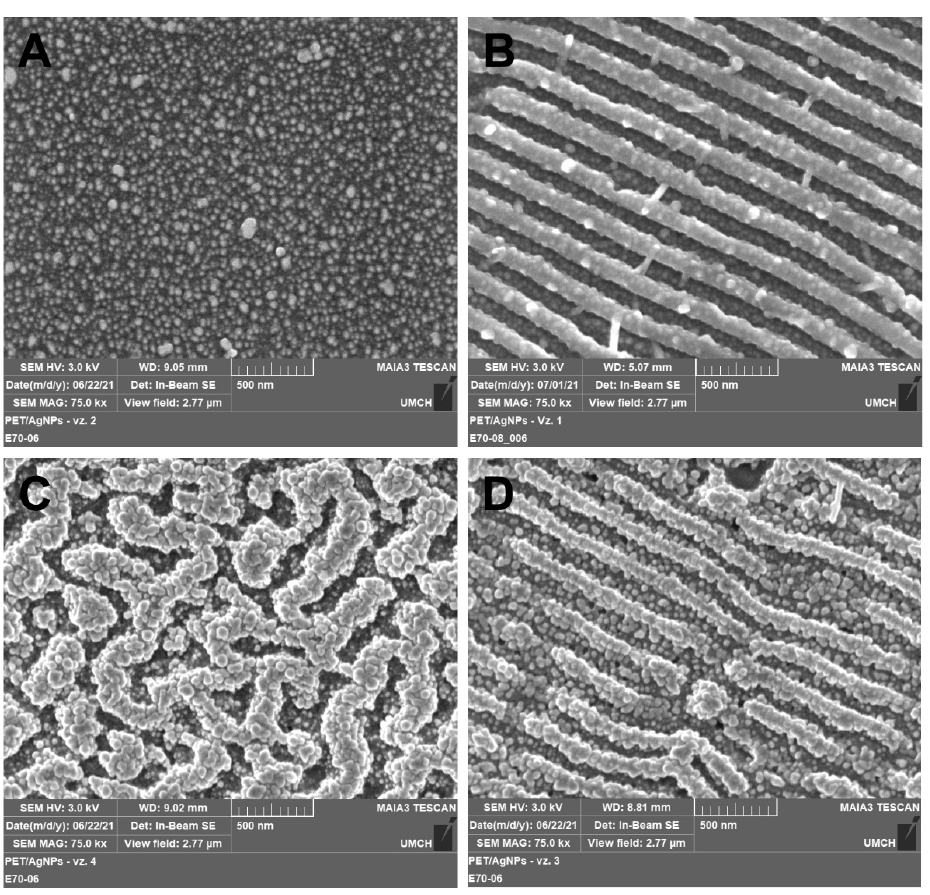
Figure 3. FEGSEM micrographs showing the surface morphology of PET immobilized with AgNPs at laser fluencies of 10 ( A , B ) and 24 mJ cm − 2 ( C , D ) on pristine PET ( A , C ) and PET with LIPSS structure ( B , D ). Micrographs were recorded with an in-beam SE detector at accelerating voltage 3 kV. Table 2. Concentrations of silver Ag3d, carbon C1s, and oxygen O1s (in at.%) in pristine, LIPSS modified, and AgNPs immobilized PET, derived from XPS analysis. The designation of the samples corresponds to Figure 2.